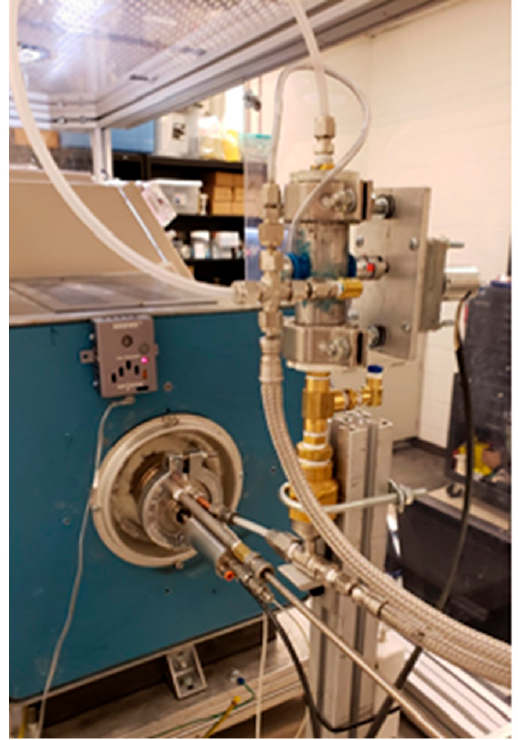
Figure 1. Custom fuel injector and particle injector attached to the inlet of the